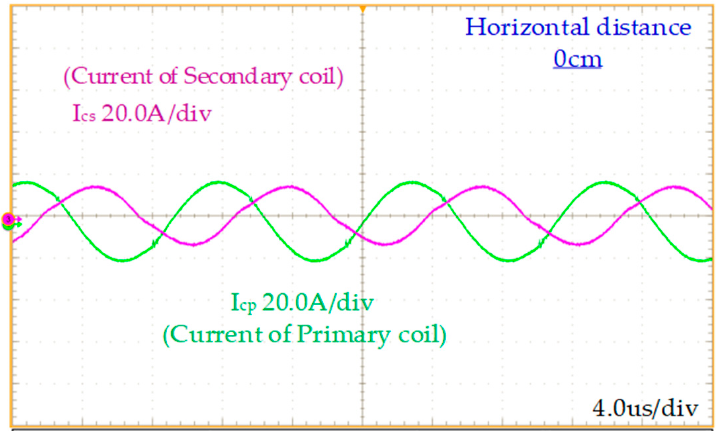
Figure 16. Current waveforms of primary and secondary coils of the 2-coil system (horizontal separation distance is 0 cm).